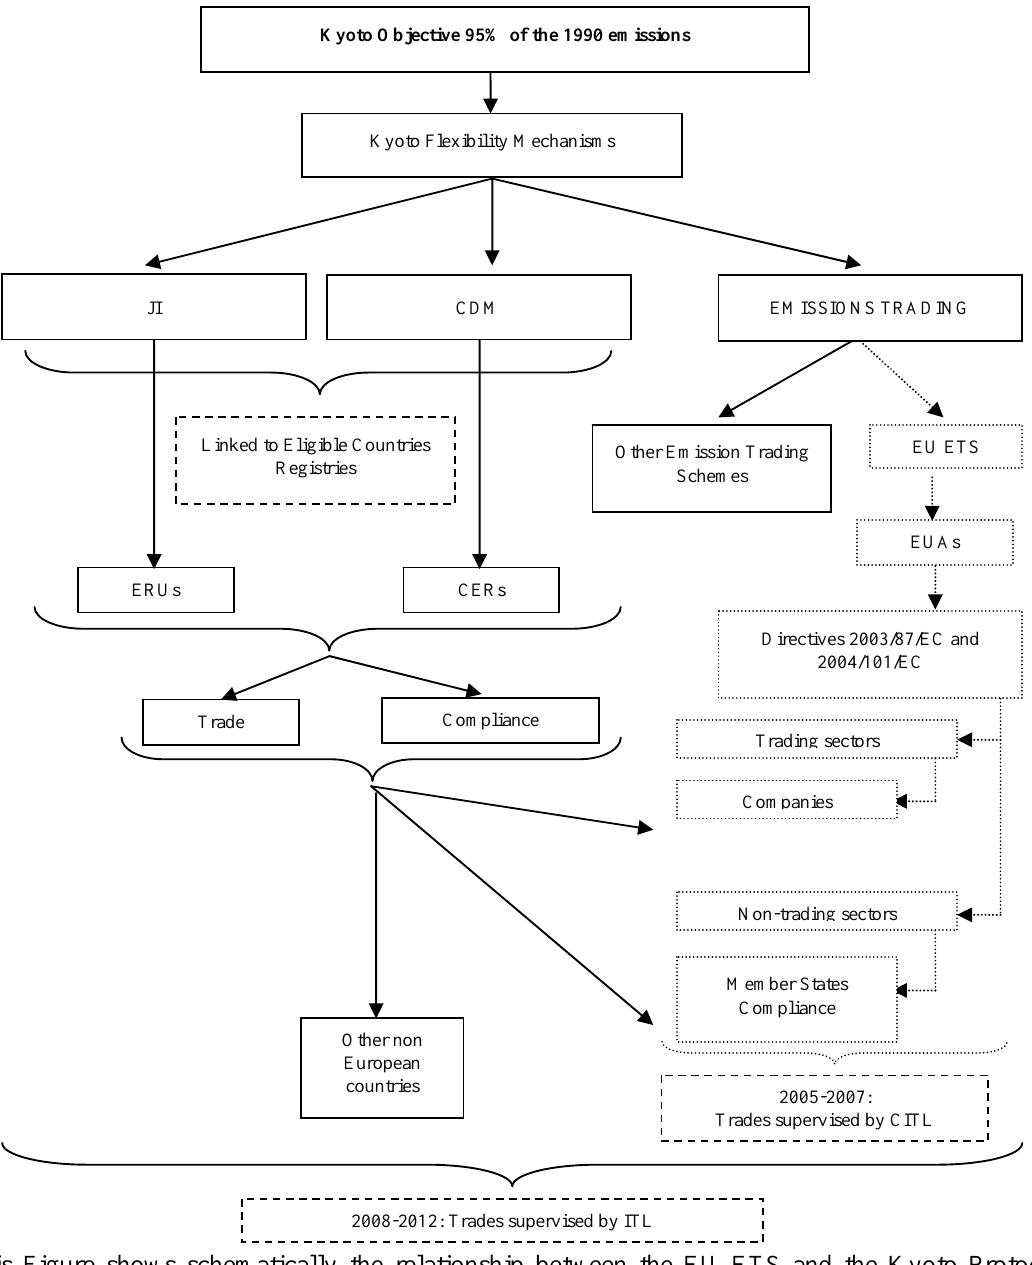
Figure 1. Kyoto Protocol Flexibility